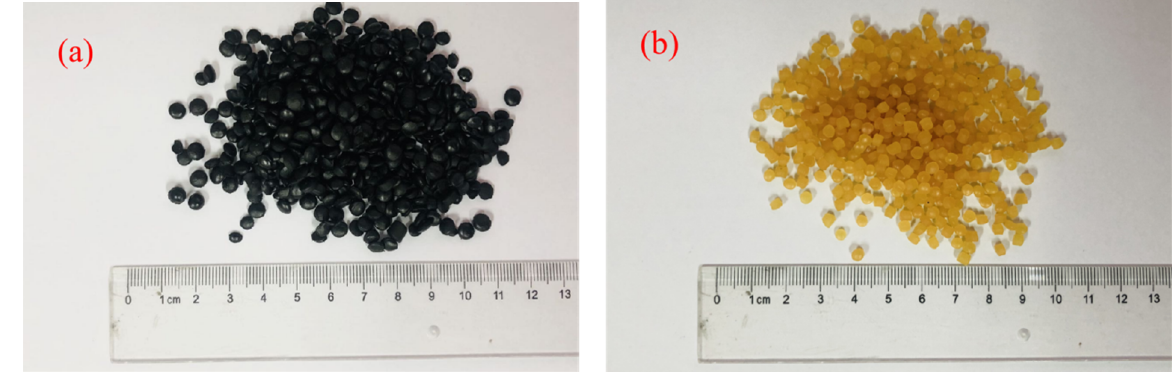
Figure 3. The appearance of two modifiers: ( a ) E-HVM modifier and ( b ) TPS modifier.